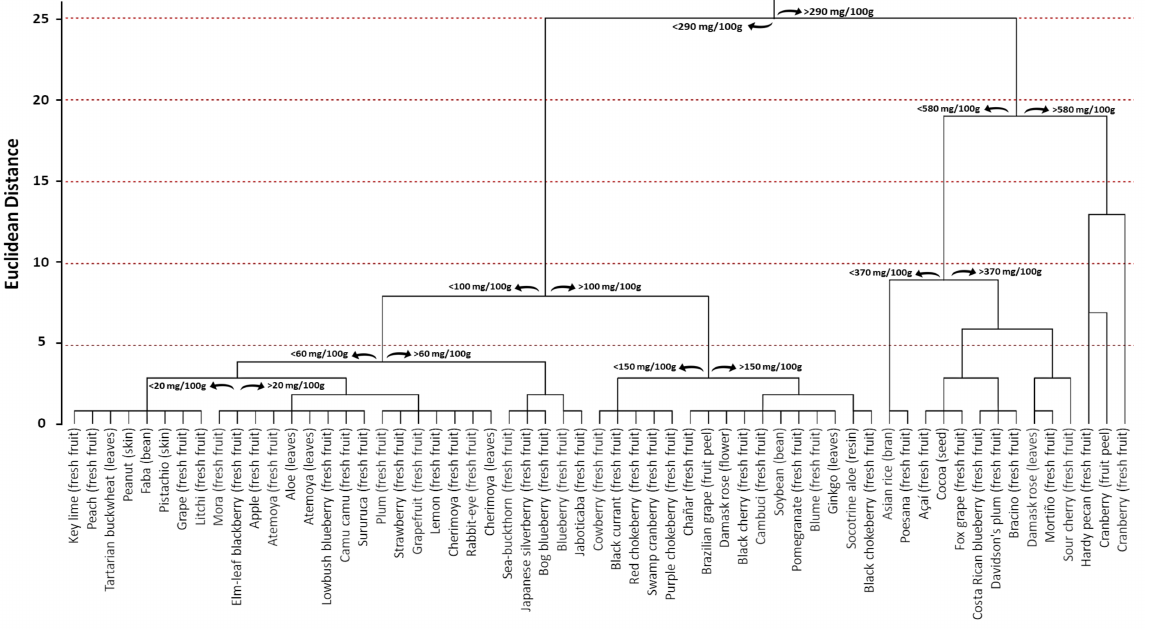
Figure 13. Cluster distribution of proanthocyanidins in plant kingdom based on the total proanthocyanidin content according to previously published data [87,88,90–93,95,96,107–139]. Euclidean distances were calculated with the average linkage method. Statistical analysis and graphical representation were made using SPSS v. 24 software. 7. PAC